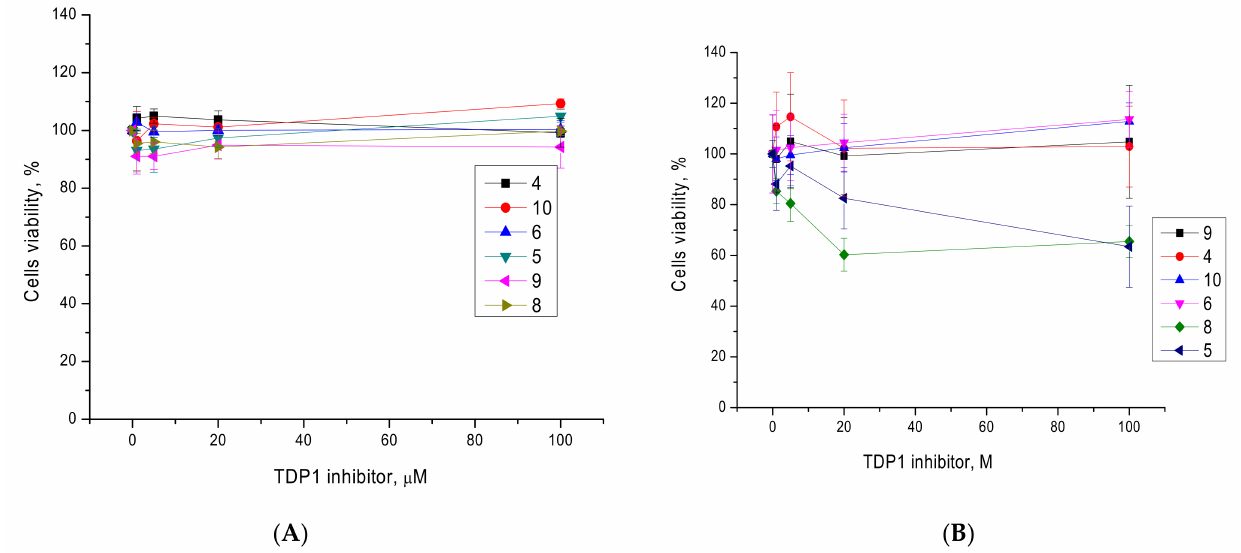
Figure 2. The influence of the TDP1 inhibitors on HEK293A ( A ) and HeLa ( B ) cell viability. The metabolic activity of the cells after 72 h of treatment according to the EZ4U